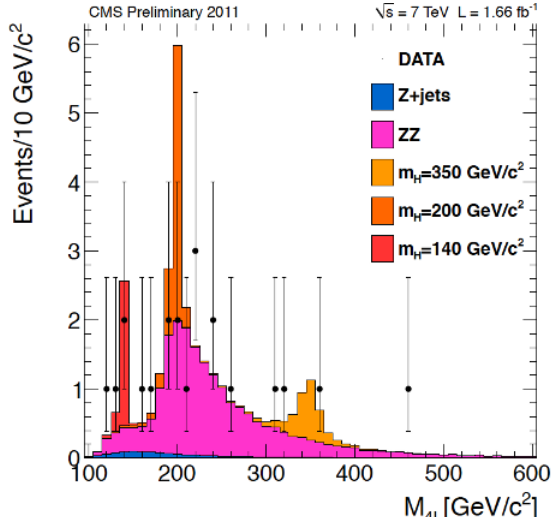
Fig. 2. Distribution of m 4 (cid:96) after the baseline selection for the sum of the 4 (cid:96) channels. Points represent the data, shaded histograms represent the signal and background expectations. The samples correspond to an integrated luminosity of L = 1 . 66 fb − 1